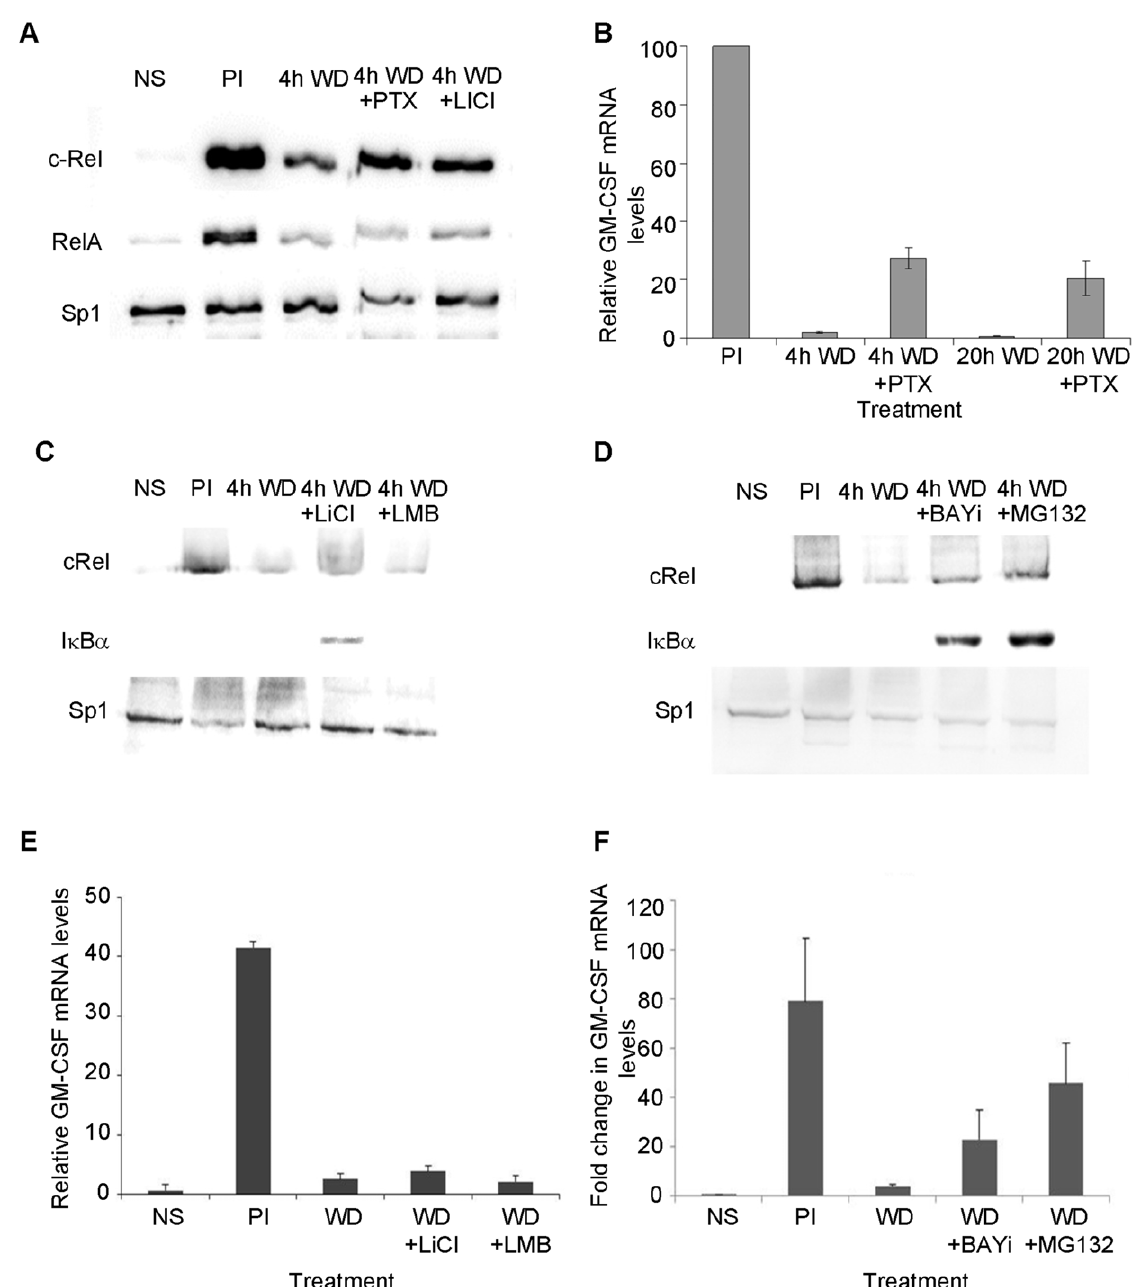
Figure 6. Transcriptional down-regulation of the GM-CSF gene is dependent on the nuclear depletion of c-Rel. (A) Nuclear extracts from EL-4 T cells either left unstimulated (NS), stimulated with PI for 4 h (PI), the stimulus withdrawn for 4 h (WD) or the stimulus withdrawn in the presence of pentoxifylline (PTX) or lithium chloride (LiCl), were subjected to western analysis with the indicated antibodies. (B) GM-CSF mRNA levels relative to GAPDH were determined in cells treated as indicated. mRNA levels are shown relative to the 4 h PI sample which was set at 100%. The mean and standard error of three independent experiments is shown. (C–D) Nuclear extracts from EL-4 T cells either left unstimulated (NS), stimulated with PI for 4 h (PI), the stimulus withdrawn (WD) for 4 h, or the stimulus withdrawn in the presence of lithium chloride (LiCl) or leptomycin B (LMB) (C) or BAY 11-7082 (BAYi) or MG132 (D) were subjected to western analysis with the indicated antibodies. (E–F) GM-CSF mRNA levels relative to GAPDH were determined in cells treated as indicated. The mean and standard deviation of two independent experiments is